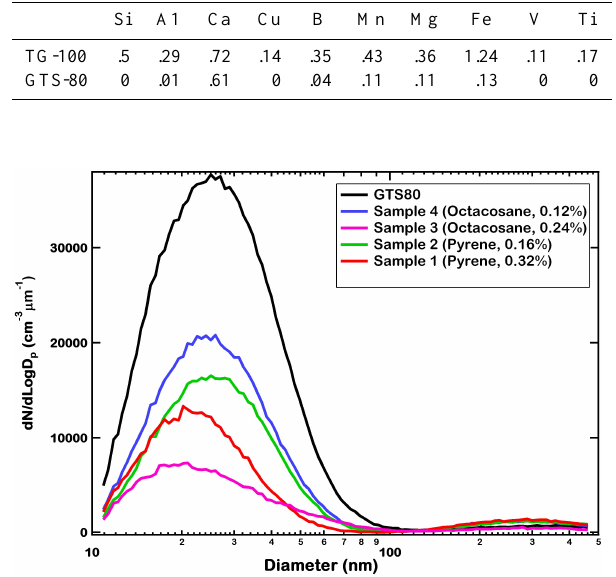
Fig. 4. These distributions show how the concentration of basic GTS-80 and GTS-80 soots with various organic coatings varies with size. Adding layers of material leads to an apparent shift in the distribution to smaller sizes but this is possibly due to changes in the shape of the particles that alter their behavior in the differential mobility